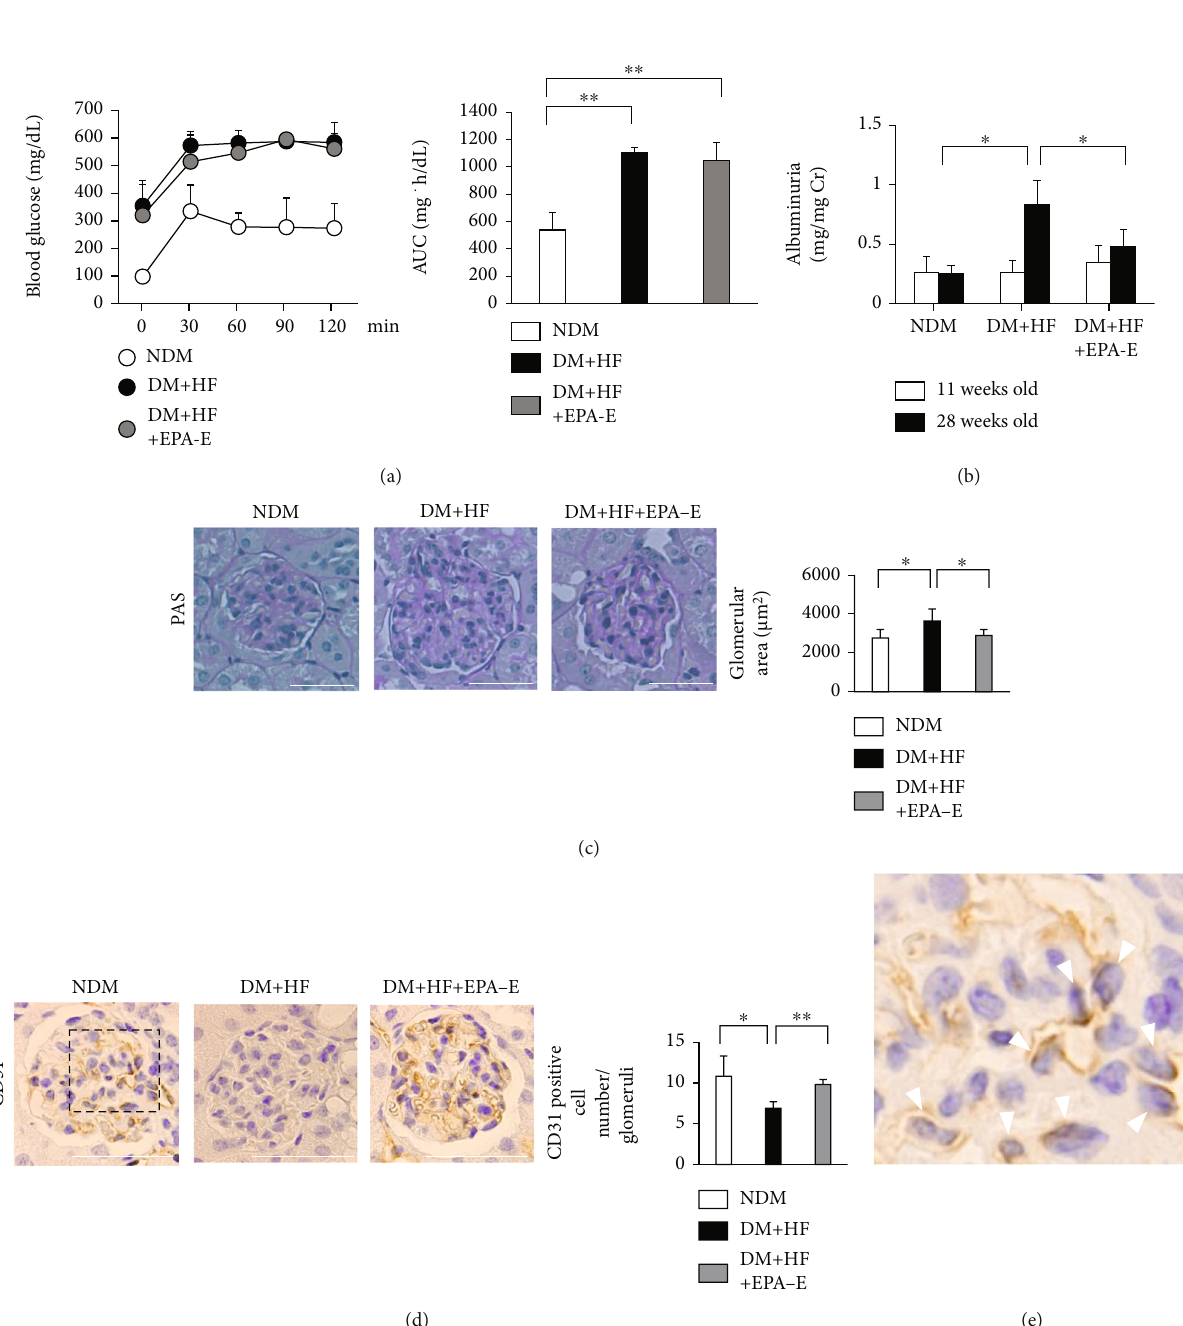
Figure 1: E ff ects of EPA-E on blood glucose, albuminuria, renal morphology, and immunohistochemical staining of CD31 in the experimental groups. (a) Intraperitoneal glucose tolerance tests were performed in the experimental groups. Time-course measurements of blood glucose is shown. The area under the curve is derived from the intraperitoneal glucose tolerance tests. (b) Albuminuria was measured by the Albuwell. (c) Representative light microscopic appearance of glomeruli (periodic acid-Schi ff ) for experimental groups. Morphometric analysis of the glomerular surface area. Bar = 50 μ m . (d) Representative immunohistochemistry of CD31 in the glomeruli. Sections were counterstained with hematoxylin solution. Bar = 50 μ m . (e) Enlarged glomerular image of the box in d. Positive nuclear staining for CD31 was localized in endocapillary area (white triangle). ∗ P < 0 : 05 . ∗∗ P < 0 : 01 . These data are expressed as means ± SD . NDM: nondiabetic mice; DM + HF : mice with STZ-induced diabetes were fed a high-fat diet; DM + HF + EPA − E : STZ-induced diabetic mice were fed a high-fat diet treated with